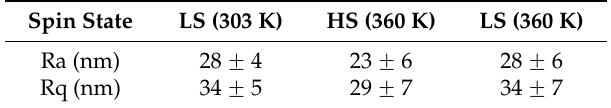
Table 1. Evolution of surface roughness parameters through the spin transition (3 × 3 μ m 2 area).